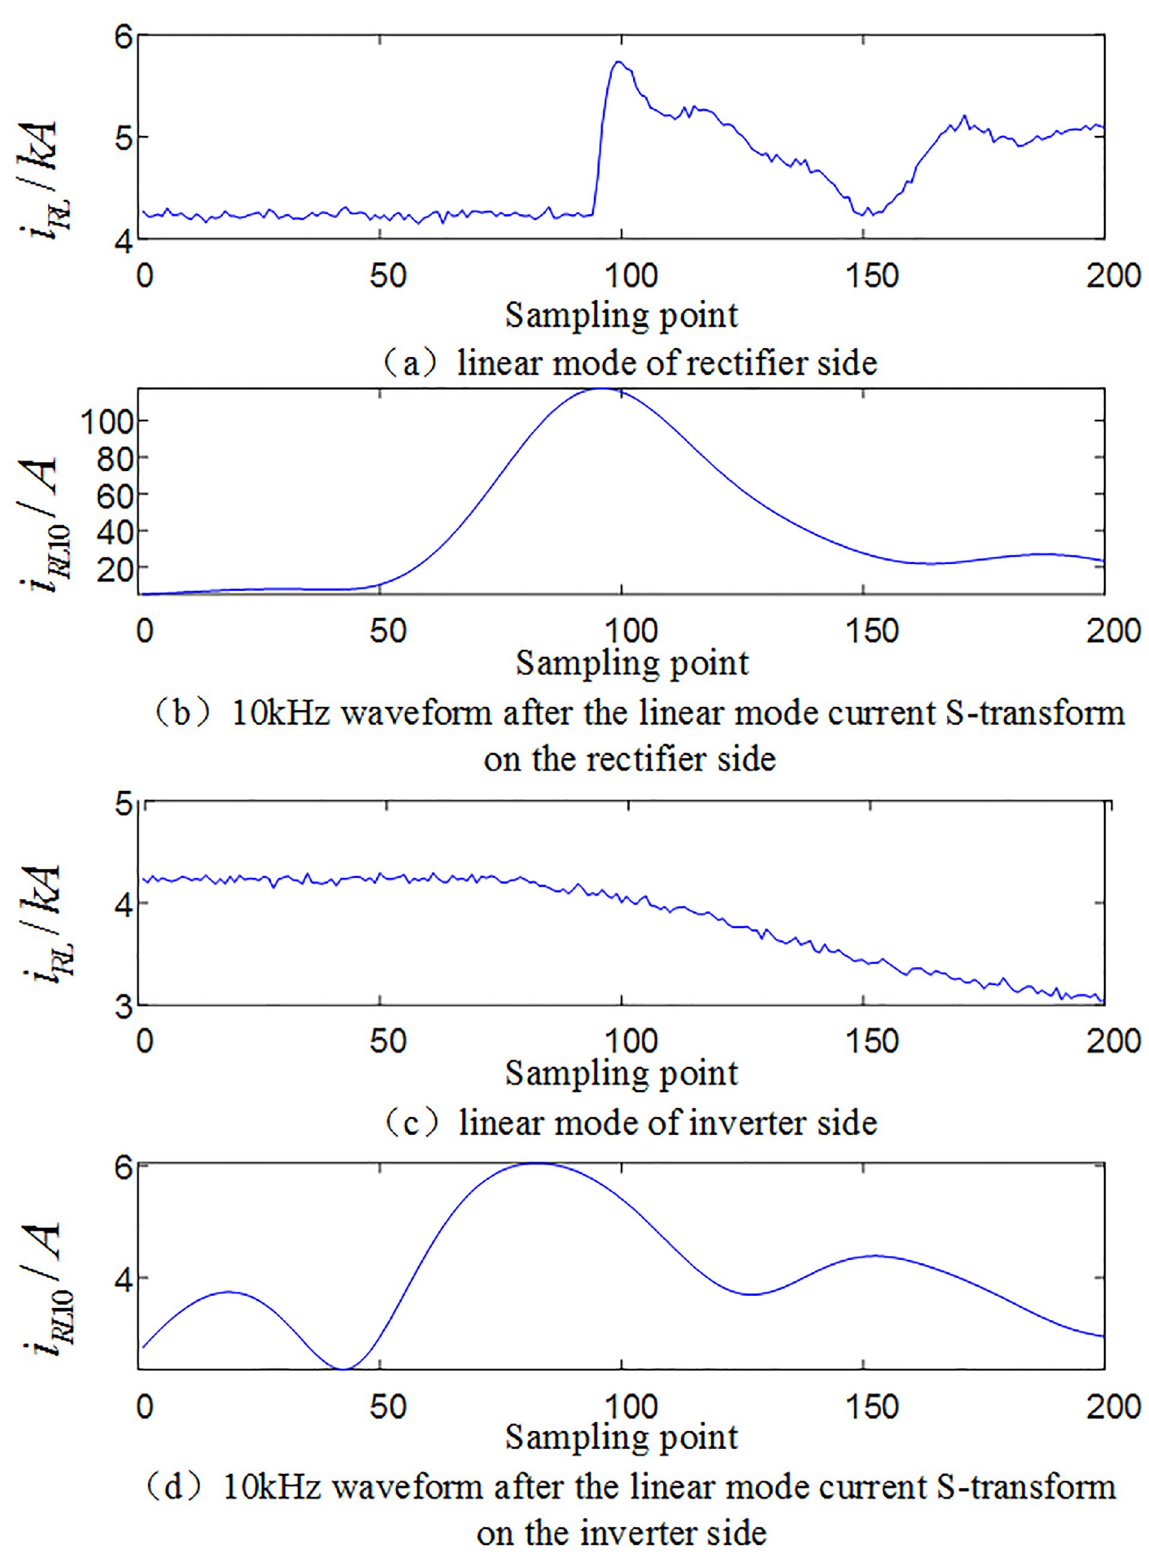
Fig 21. Correlation waveforms in the case of SNRs = 30dB.